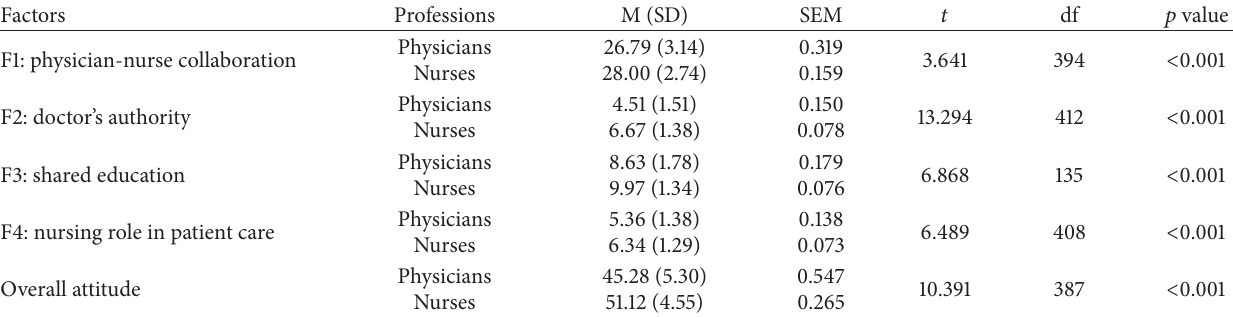
Table 2: Mean values and differences between physicians and nurses according to JSAPNC domains.